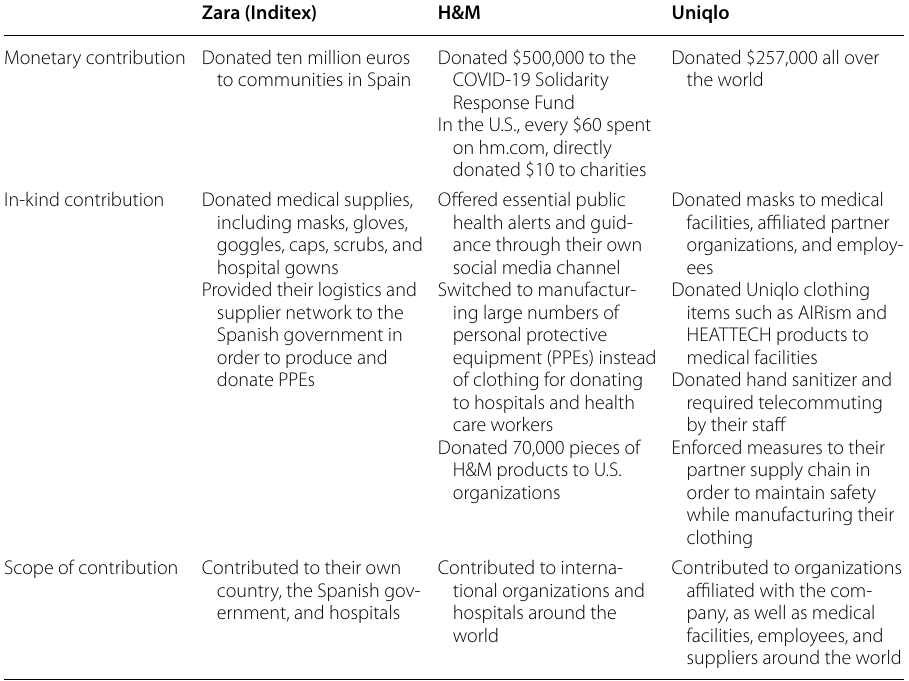
Table 5 Comparison of retailers’ monetary and in-kind contributions during the COVID-19